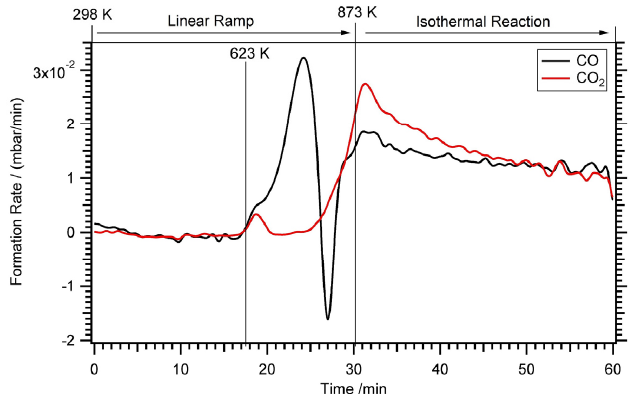
Figure 3. MSR on the CVD grown ZrO x H y model catalyst under water-rich MSR conditions (water:methanol = 2:1, p total = 36 mbar). The exposure was about 1000 L ZTB at 700 K and the initial coverage with Zr estimated to ~0.4 ML. The temperature range of the MSR experiment was extended to 873 K.